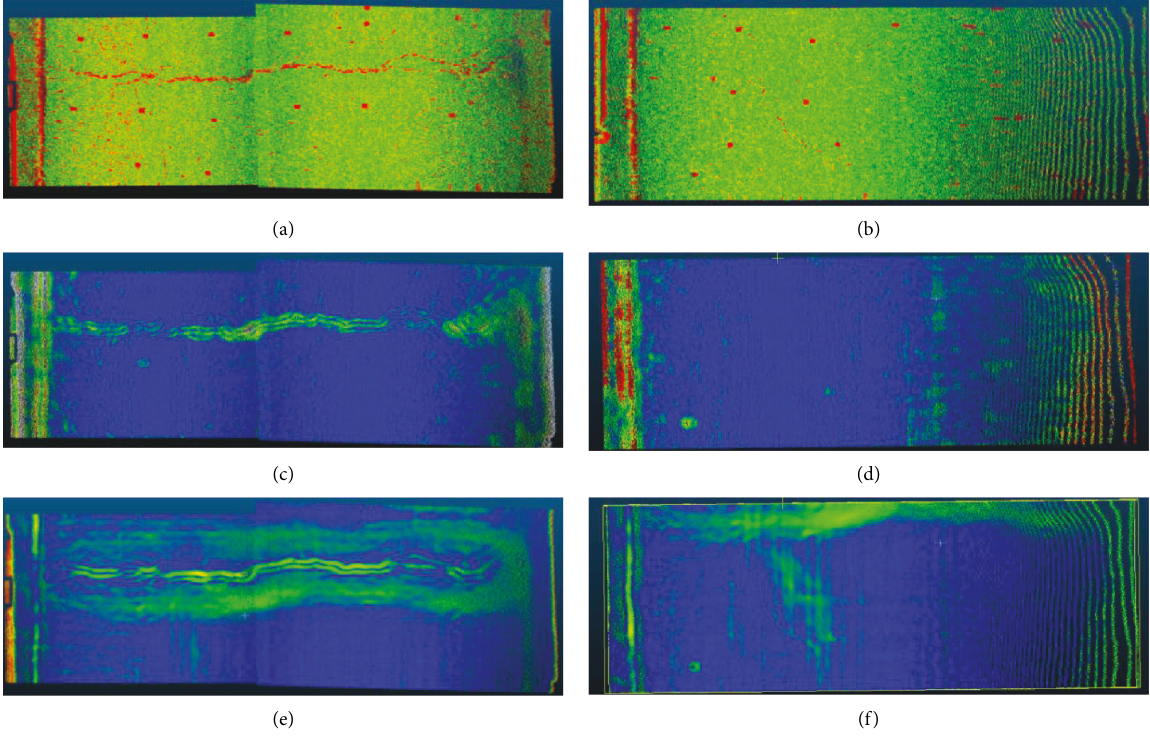
Figure 7: The results of data processing. The columns show the results of large crack (a, c, e) and small crack (b, d, f). The rows show the results of crack points extraction using intensity gradient (a, b), inclined angle (c, d), and dip angle (e,